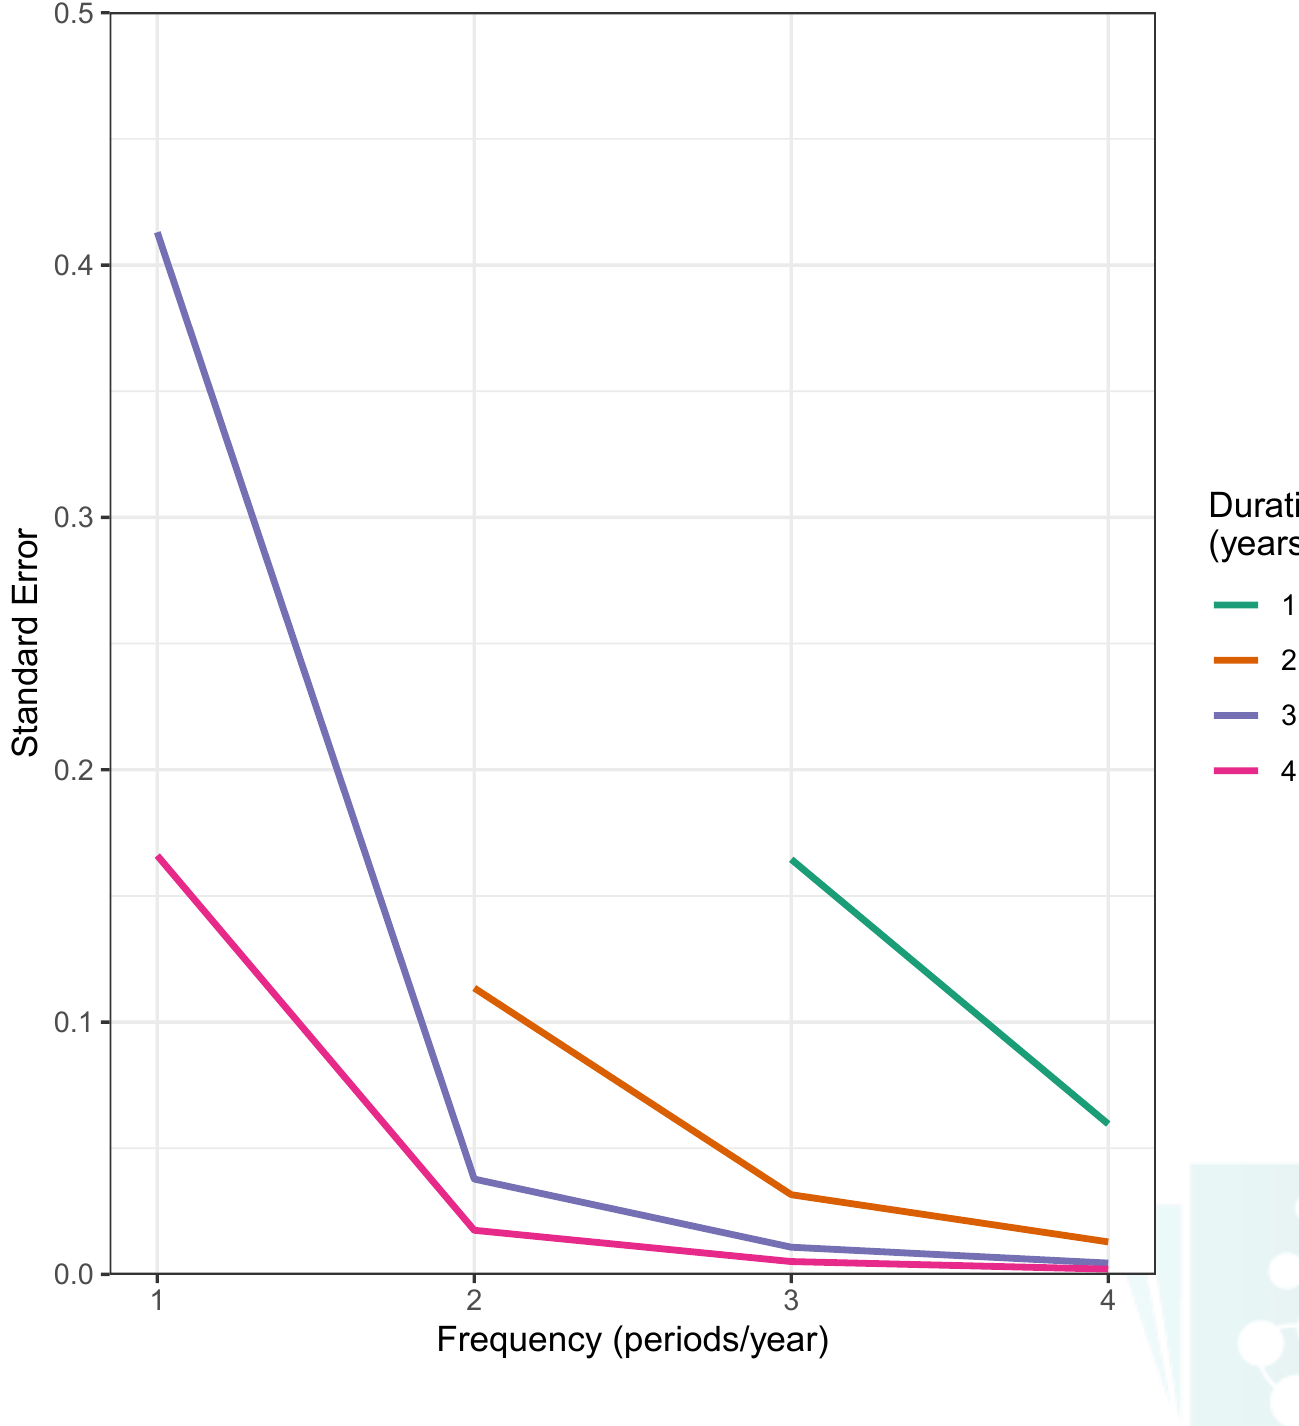
Figure 1: Standard errors for the estimated regression coefficients of the Group-Time-Time interaction term for combinations of study duration and frequency of outcome